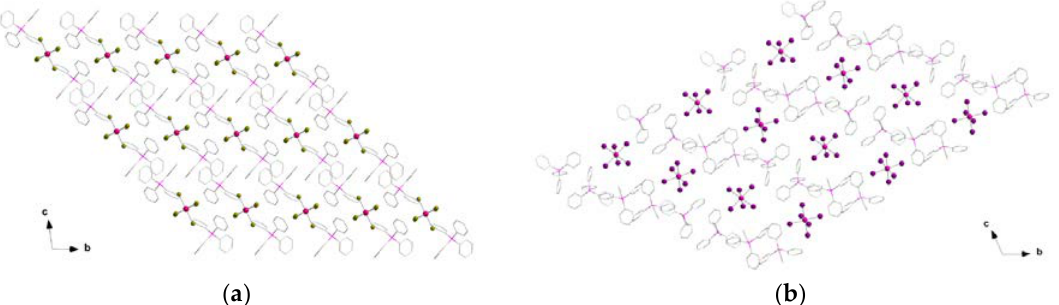
Figure 2. View along the crystallographic a axis of a fragment of the crystal packing of 1 ( a ) and 2 ( b ) showing the arrangement of the [ReX 6 ] 2− anions (ball and stick model) and PPh 4 + cations (wireframe model).